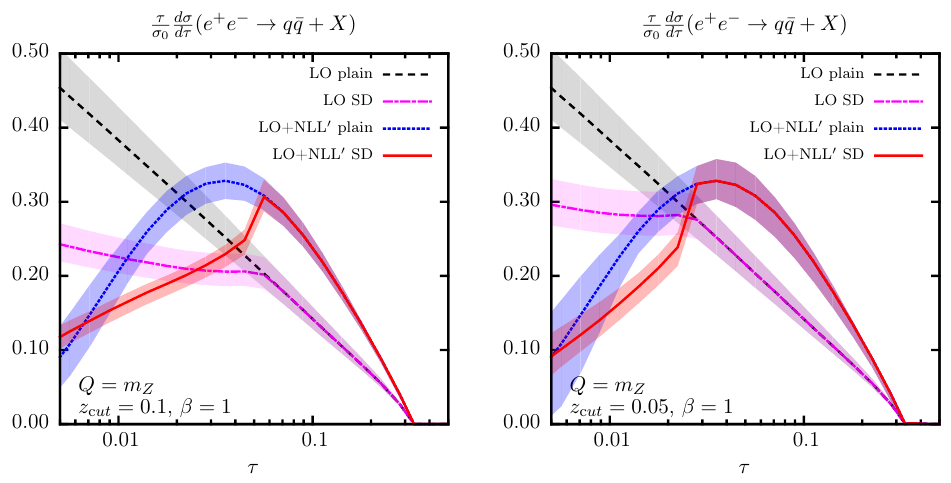
Figure 7 . Same as (cid:12)gure 6 but now for soft drop applied with angular exponent (cid:12) =